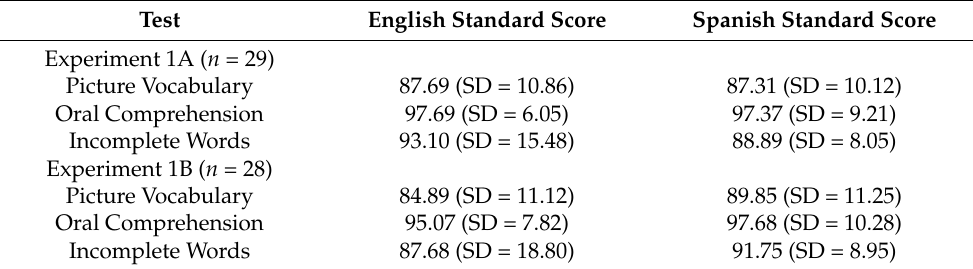
Table 1. Participant performance on language measures 1